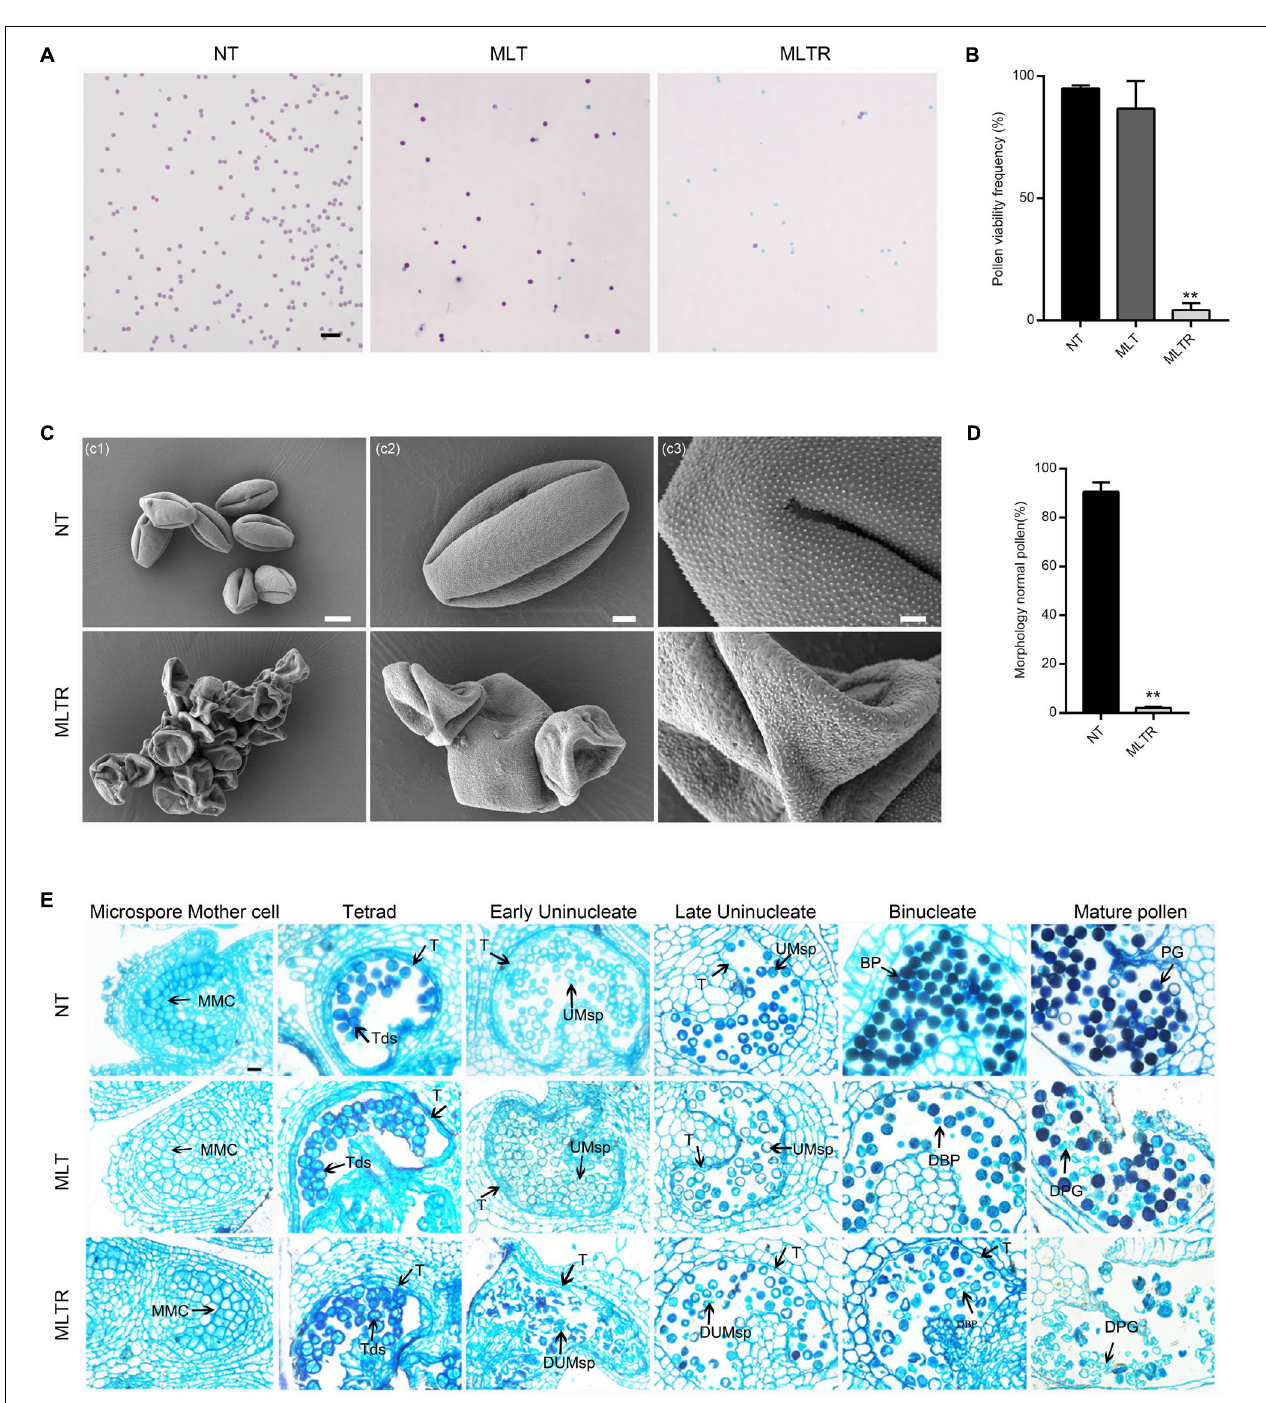
FIGURE 1 | Moderate low temperature (MTL) stress at the tetrad stage affects pollen development in tomato. (A) Alexander staining of mature pollen grains from the plants exposed to normal temperature (NT), MLT-stress and returned to normal growing temperature for recovery after moderate low temperature treatment (MLTR). Scale bars = 100 µ m. (C) Scanning electron microscopy indicated that MLTR-stress pollen grains were seriously shrunk and collapsed, appearing aggregated. Scale bars c1 = 10 µ m; c2 = 3 µ m; c3 = 1 µ m. (B,D) Quantification of viable mature pollen grains and morphology normal pollen from NT, MLT, and MLTR plants, respectively. Each value is the mean ± SD ( n = at least three biological replicates with 15 plants each). * P < 0.05; ** P < 0.01 (two-tailed Student’s t- test). (E) Semithin cross sections of anthers in different stages under NT and MLT condition. The tapetum degeneration was postponed under MLTR compare to NT condition. MMC, microspore mother cell; Tds, tetrads; UMsp, uninucleate microspore; BP, binucleate pollen; PG, pollen grains; DUMsp, degenerated uninucleate microspore; DBP, degenerated binucleate pollen; DPG, degenerated pollen grains; T, tapetum. The experiment was repeated three times independently with consistent results. Scale bars = 20 µ